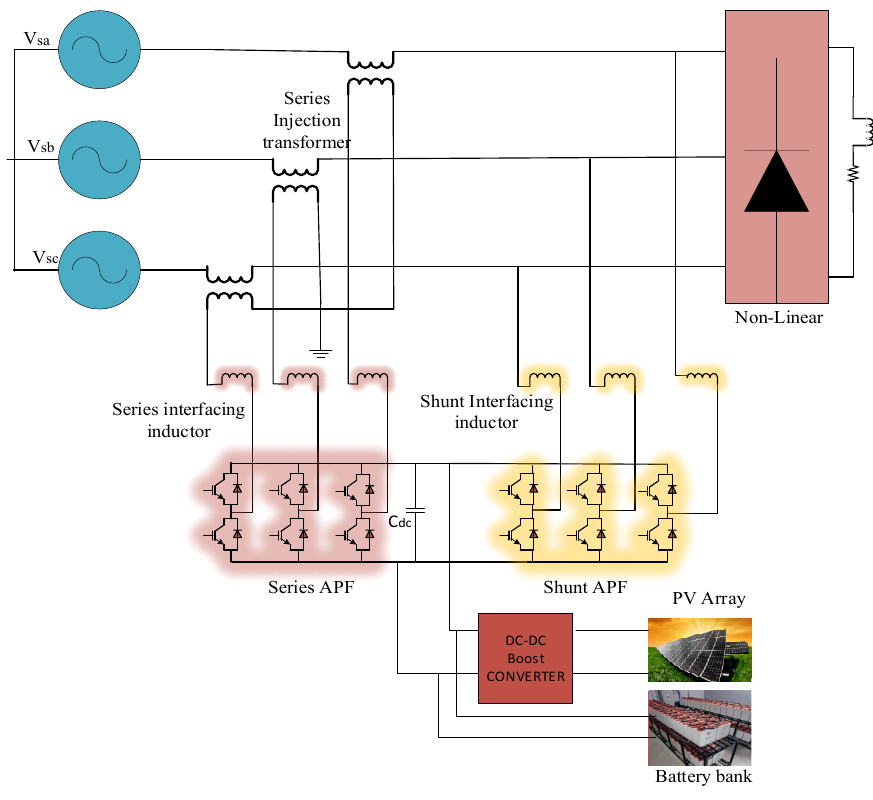
Figure 1. Block diagram of a system.